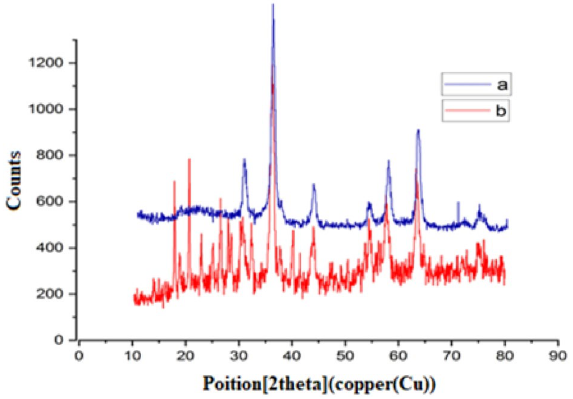
Figure 3. The XRD pattern of MNP–(CH 2 ) 3 Cl ( a ) and MNP–(CH 2 ) 3 Cl/Glycerol-Cu ( b ).